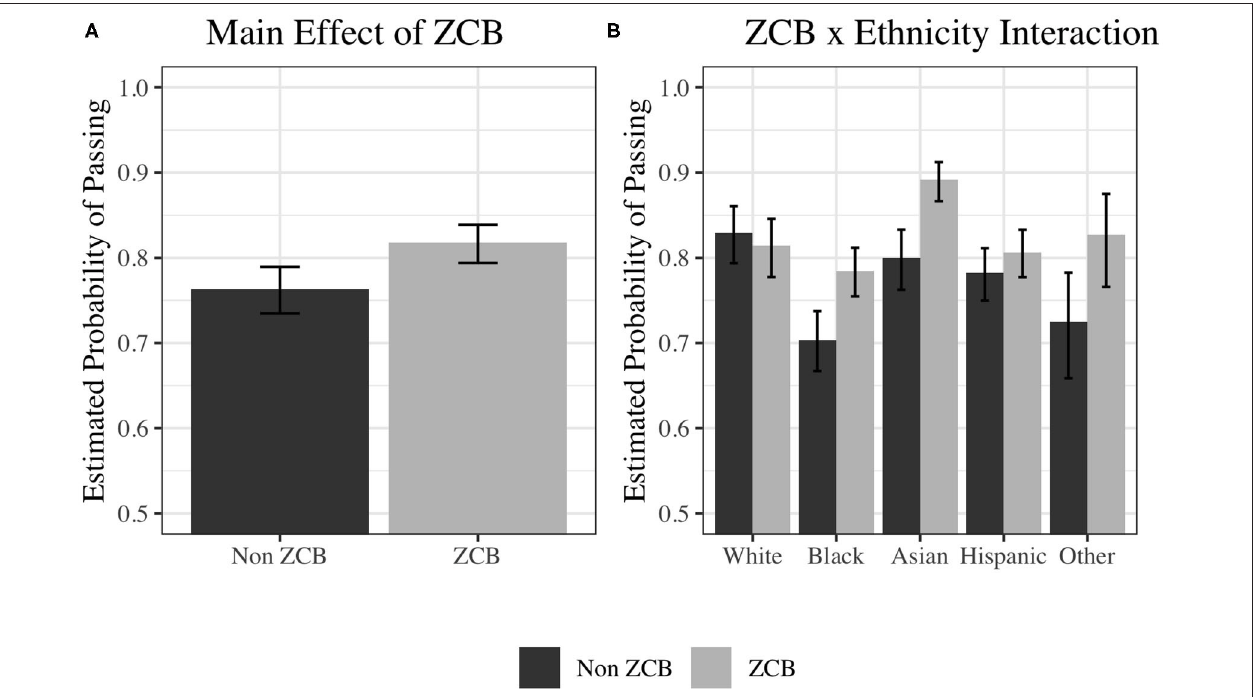
FIGURE 2 | Estimated marginal probability of passing after controlling for confounding variables. (A) Shows the overall main effect of ZCB, generated using the main effect model. (B) Shows the interaction effects between ethnicity and ZCB, generated using the interaction model. Error bars are standard